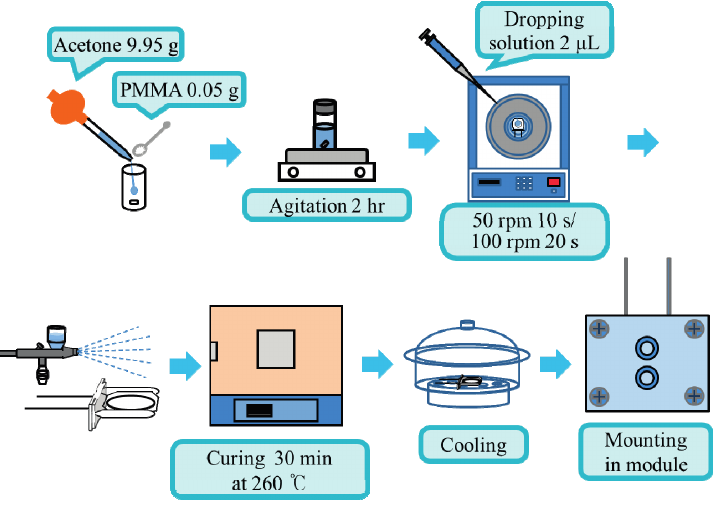
Figure 1. Flowchart of the preparation procedure of zeolite-coated quartz crystal microbalance.